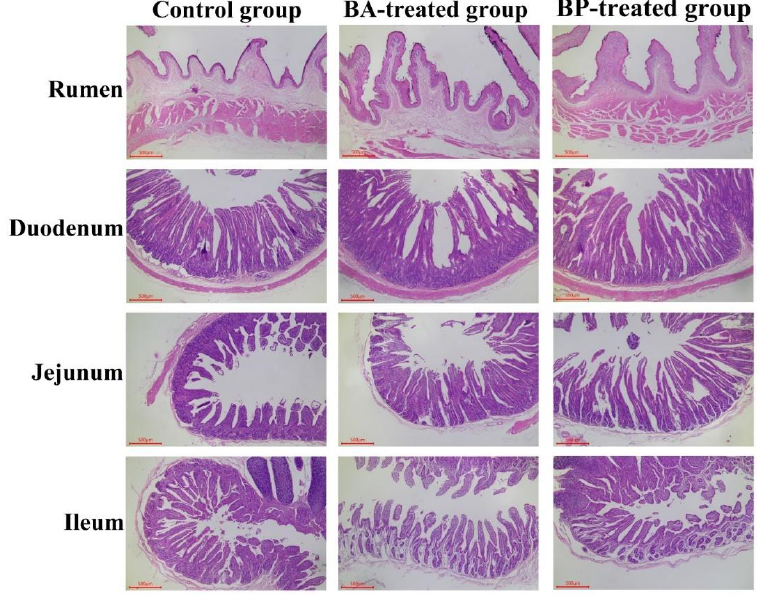
Figure 1. Cross-section of hematoxylin and eosin marking the rumen and small intestine. Table 2. E ff ects of probiotics on the black goat rumen and small